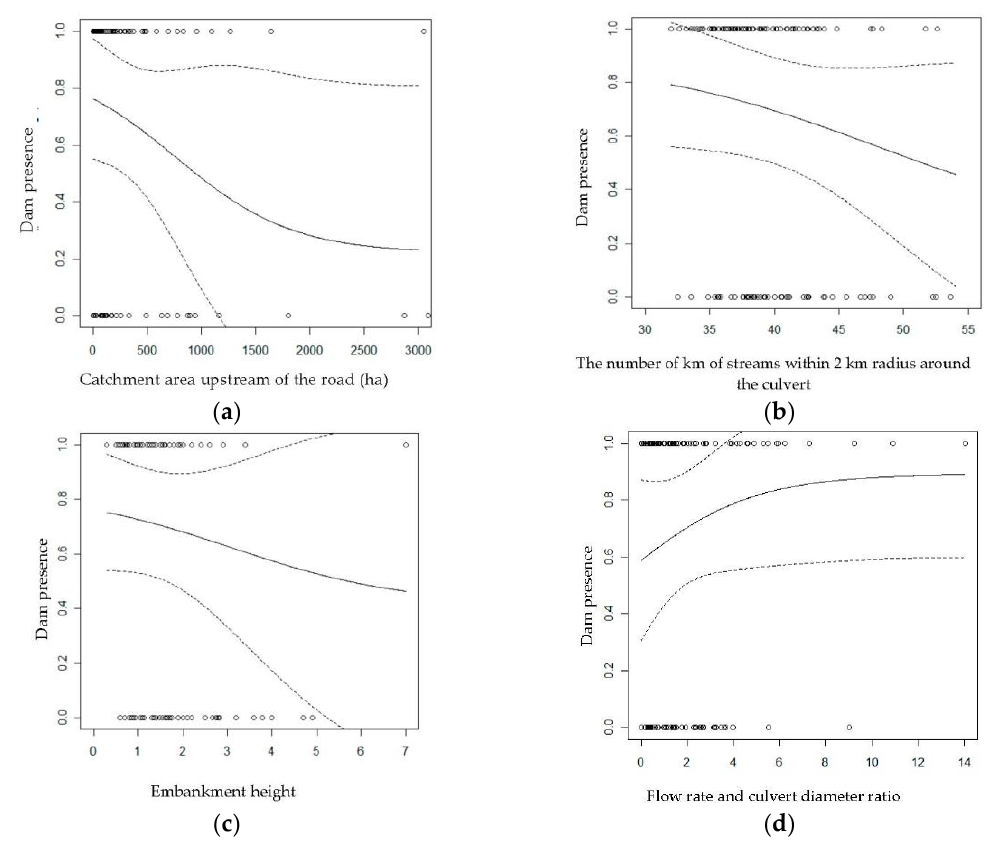
Figure 2. Probability of dam presence near culverts according to ( a ) BDTQ catchment area upstream of the road, ( b ) the number of km of streams within 2-km radius around the culvert, ( c ) embankment height and ( d ) BDTQ flow rate and culvert diameter ratio. The dotted lines represent 95% confidence bands and dots represent sample culverts ( n = 128).